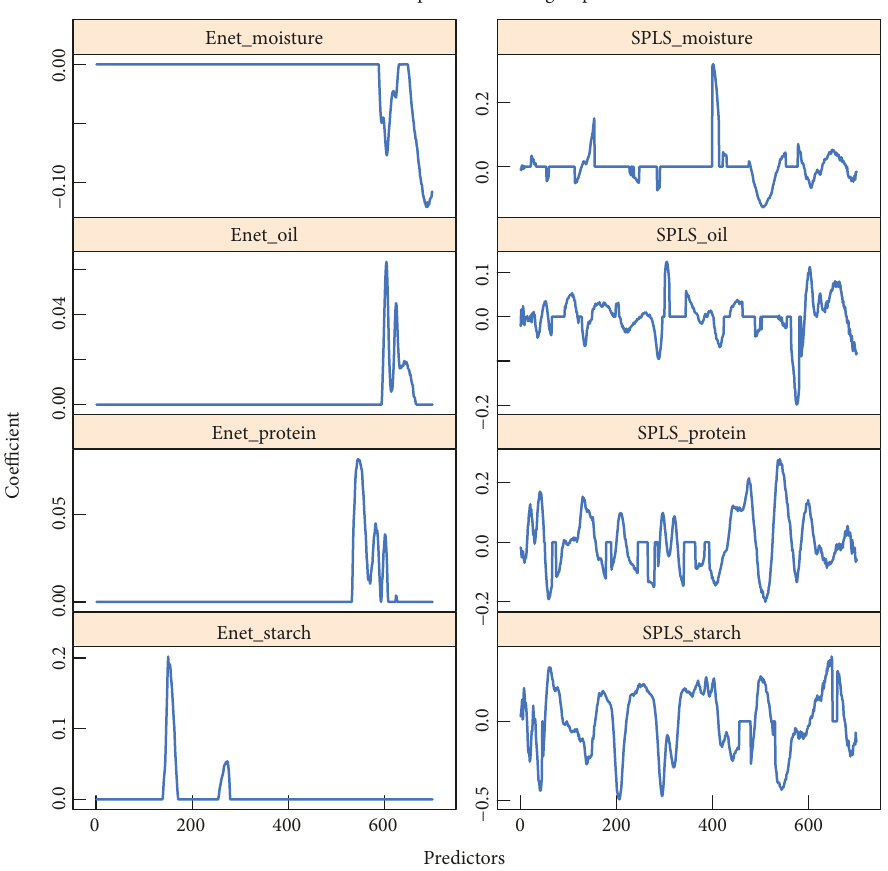
Figure 6: The coefficient paths of predictor matrix “m5spec” with four responses from corn data set. The left and right four panels are generated by Enet and SPLS, respectively. All the panels show that the coefficients paths are segmentally zero-valued or nonzero-valued, so two methods select successive wavelength intervals as key variables.